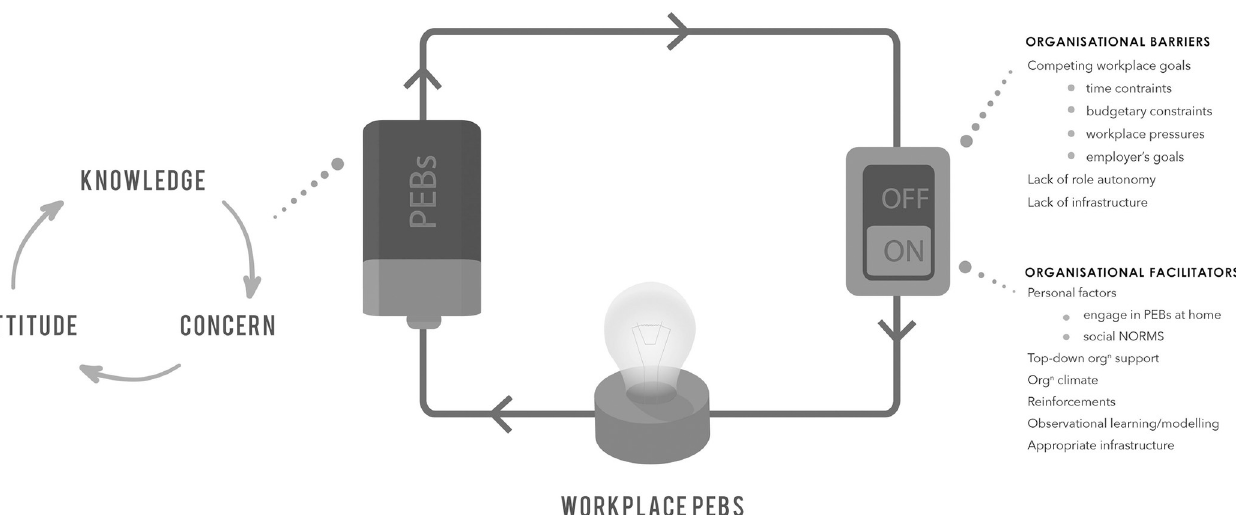
PLOS ONE | https://doi.org/10.1371/journal.pone.0255445 August 18,